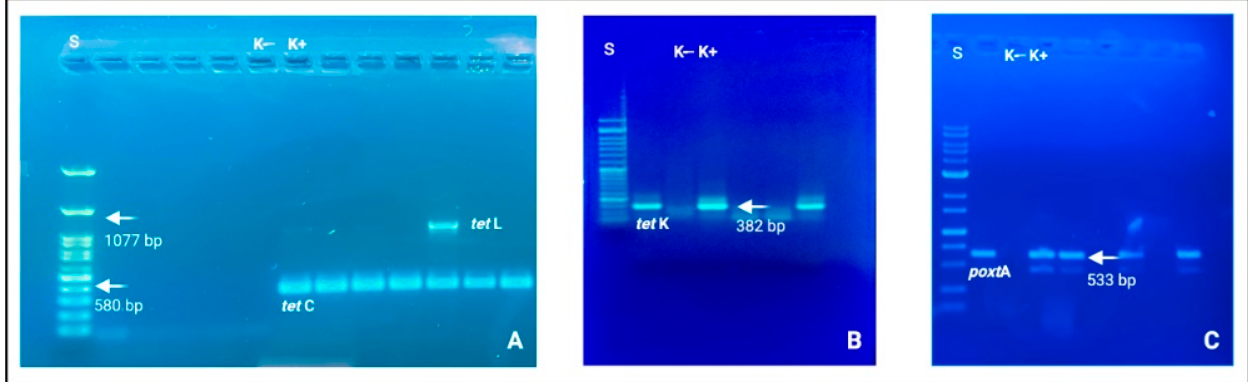
Figure 2. Electrophoresis gels (agarose 1.0 and 1.5%) in which it is possible to observe nitid positive amplicons and amplification results. ( A ) tet C (580 bp) and tet L (1077 bp); ( B ) tet K (382 bp); ( C ) poxt A (533 bp). Loading wells: S: DNA ladder 1 Kb (Genetic ® FastGene 100–10,000 bp DNA Marker, Düren, Germany); K − : negative control and K+: positive control.